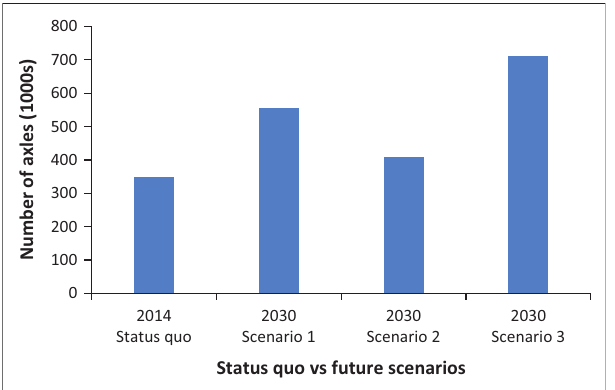
FIGURE 4: South Africa’s projected road transport fleet size based on modal shift scenarios.